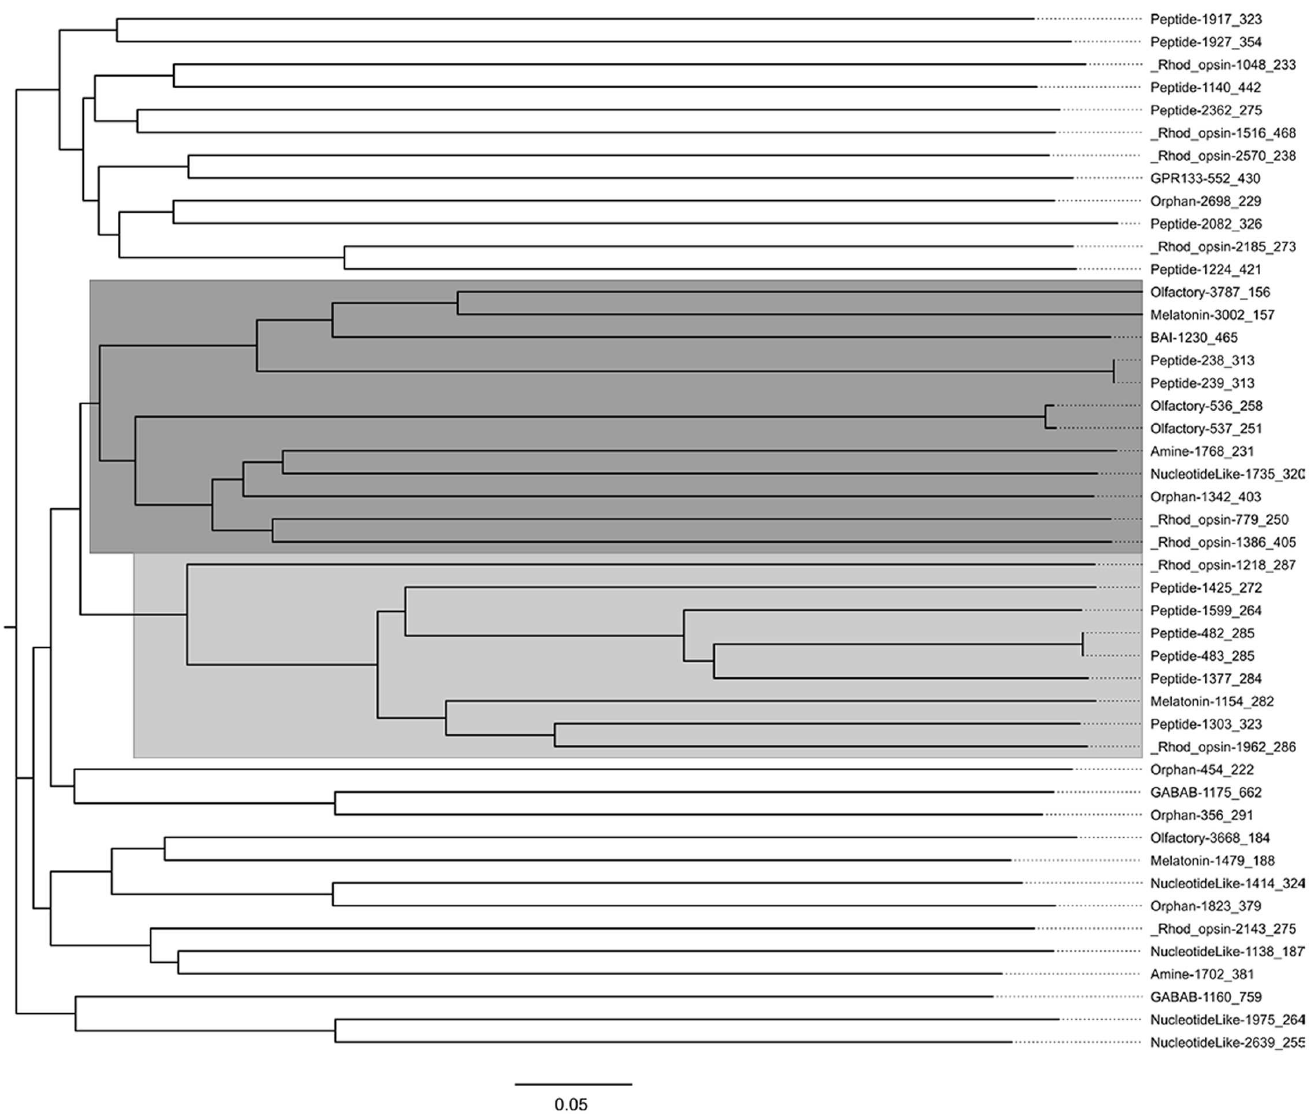
Fig 4. Phylogenetic tree of the ORFs that were predicted by 3 or more approaches. Cladescontaining clusters of ORFs from the same GPCR subfamilies are